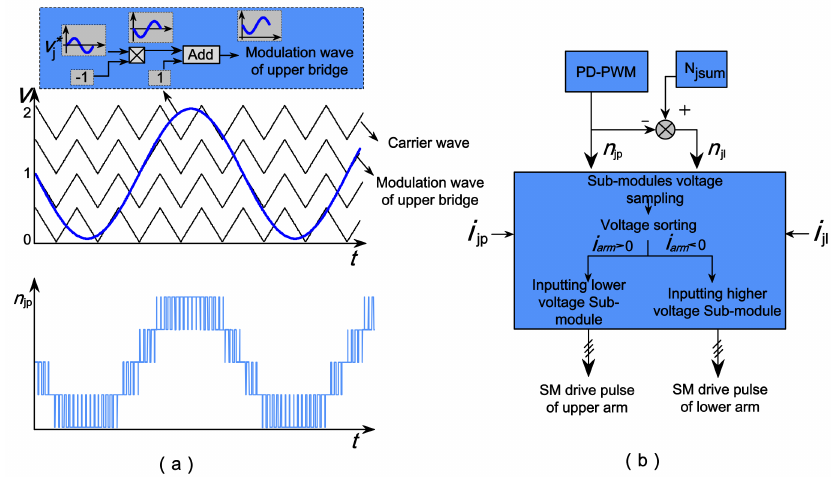
Figure 2. Schematic diagram basic control: ( a ) Diagram of the pulse-width modulation (PD-PWM); ( b ) Diagram of the capacitor voltage sorting